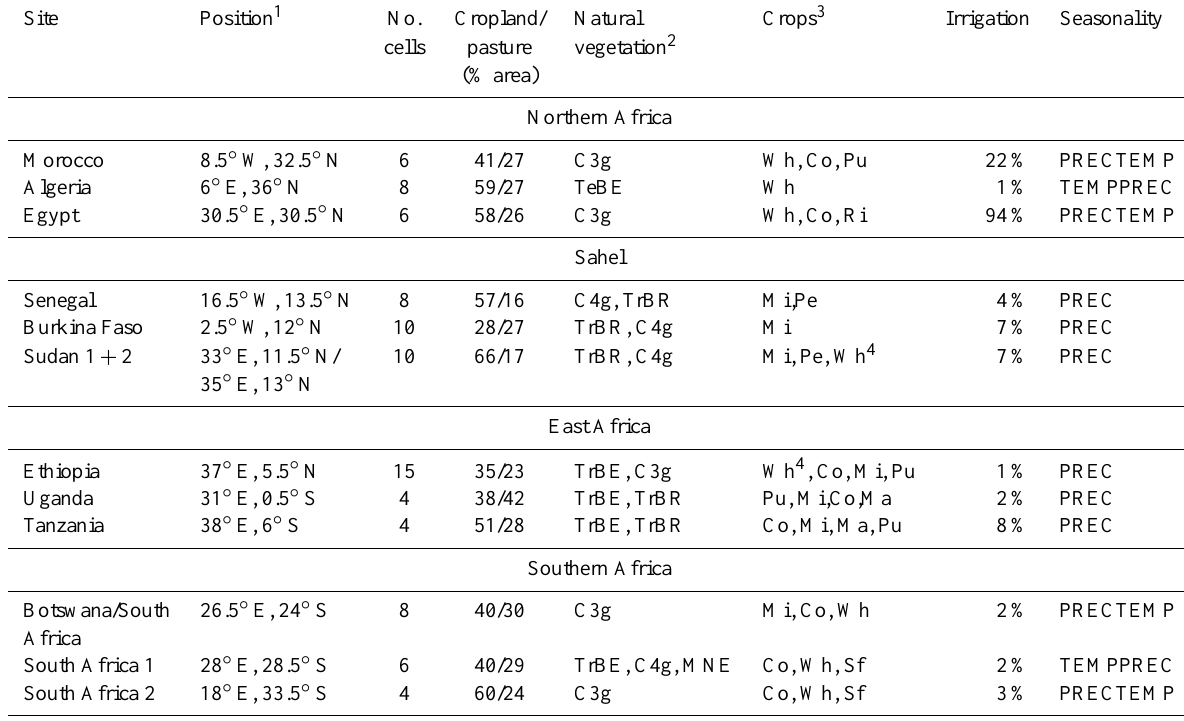
Table 4. Selected crop-intensive areas used in the FPAR-NDVI